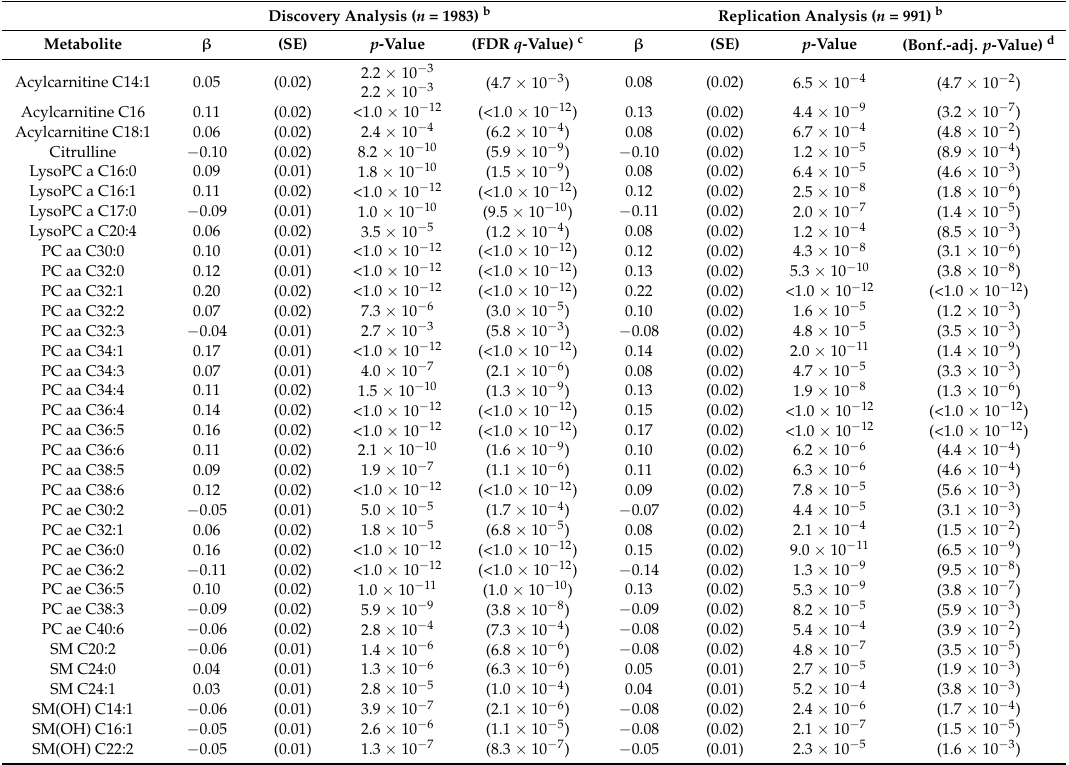
Table 2. Results of discovery and replication analysis of metabolites that were significantly associated with alcohol consumption in the discovery and replication set a